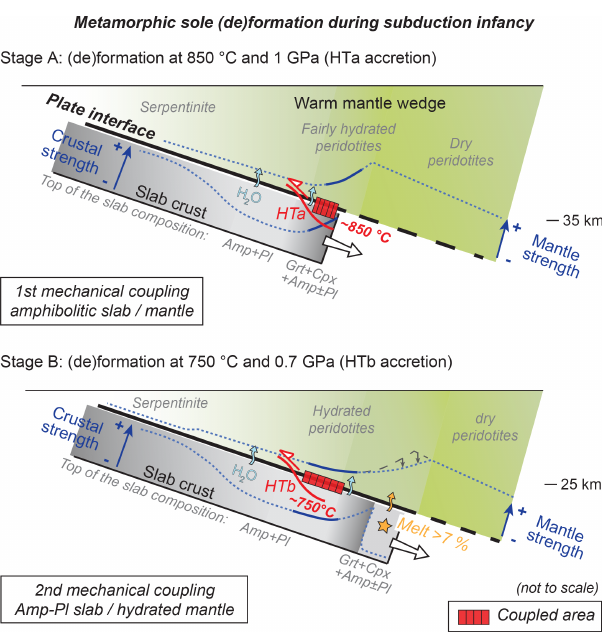
Figure 14. Schematic view of the strength evolution in the top of the slab crust and in the peridotite across the nascent subduction in- terface. Strong and transient interplate mechanical coupling allows the detachment and accretion of HTa and HTb metamorphic sole units to the peridotite (of the future